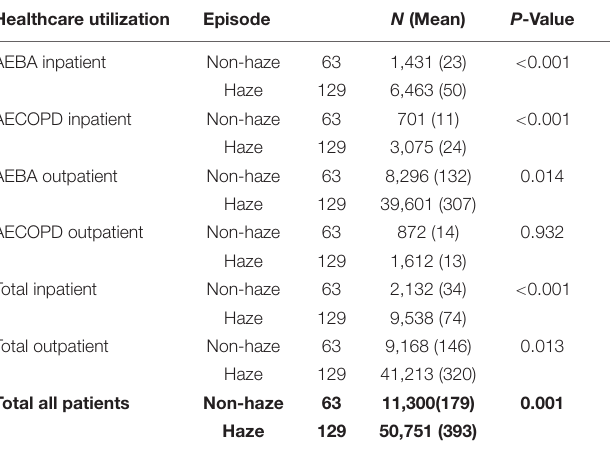
TABLE 3 | Association between healthcare utilization and haze